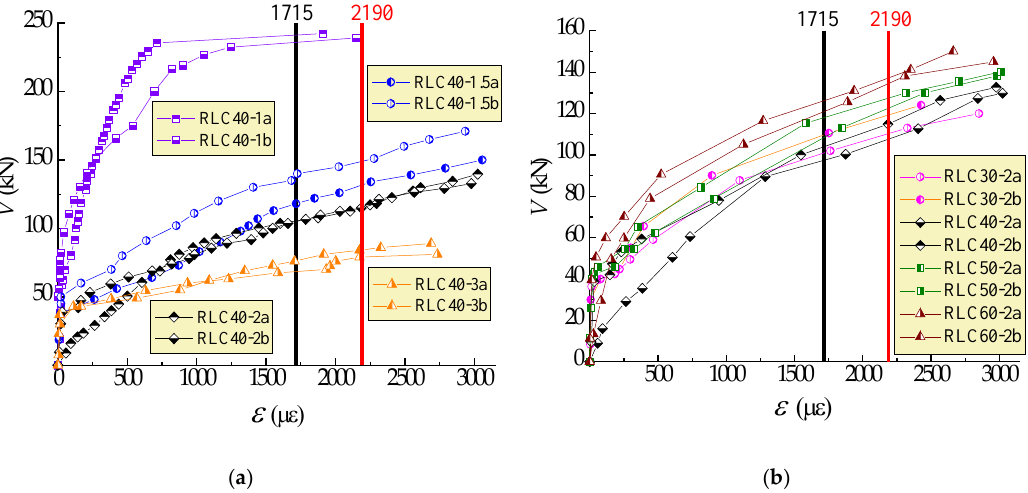
Figure 7. Strain of stirrups intersected critical diagnol cracks of test beams: ( a ) λ = 1~3; ( b ) C30~C60.